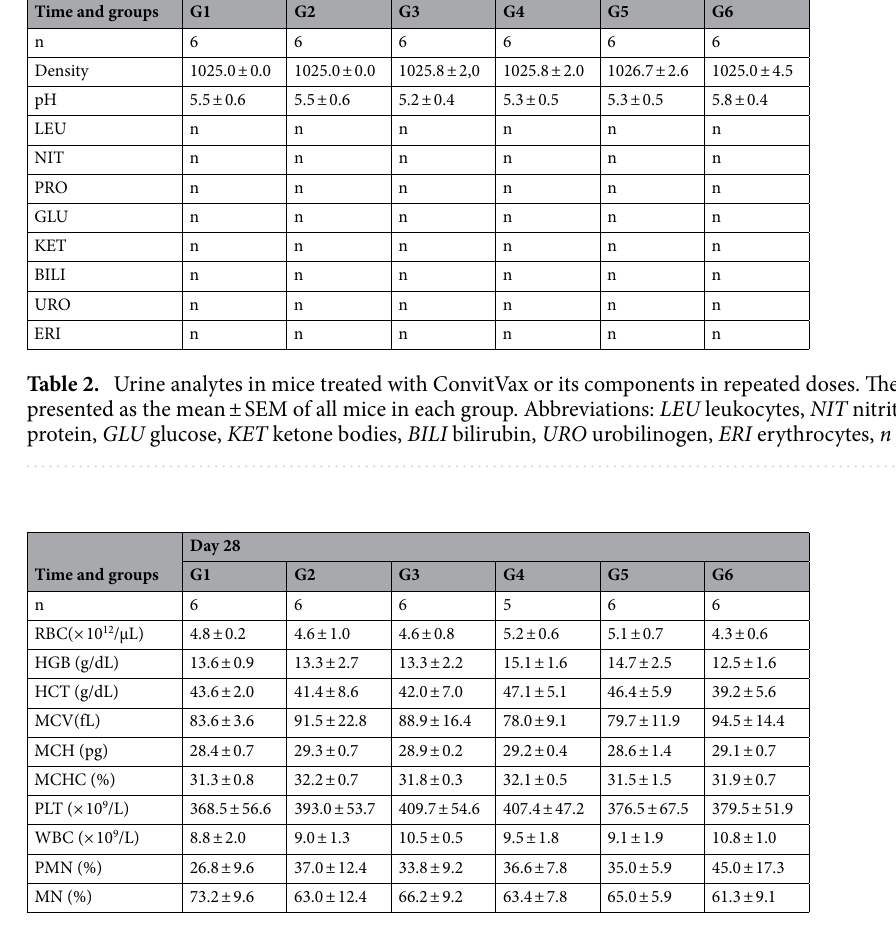
Table 3. Hematologic analysis in mice treated with ConvitVax or its components in repeated doses. It is important to mention that due to the difficulty of the exsanguination procedure, in some cases an insufficient amount of sample was obtained for the complete analysis. Therefore, the number of mice was variable and is shown in the table. The data is presented as the mean ± SD of all mice in each group. Abbreviations: RBC red blood cell count, HGB hemoglobin concentration, HCT hematocrit, MCV mean corpuscular volume, MCH mean cell hemoglobin, MCHC mean cell hemoglobin concentration, PLT platelets, WBC white blood cell count, PMN polymorphonuclear leukocyte, MN mononuclear leukocytes.